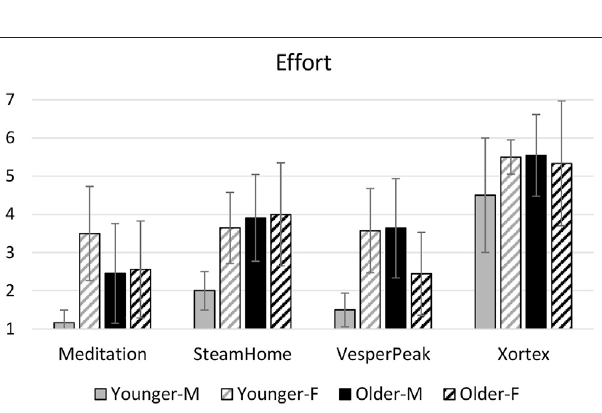
FIGURE4| Effortasafunctionofage,gender,andVRExperience.Error bars represent 95% Con fi dence Intervals. N (cid:1) 6 younger males, 14 younger females, 11 older males, 9 older